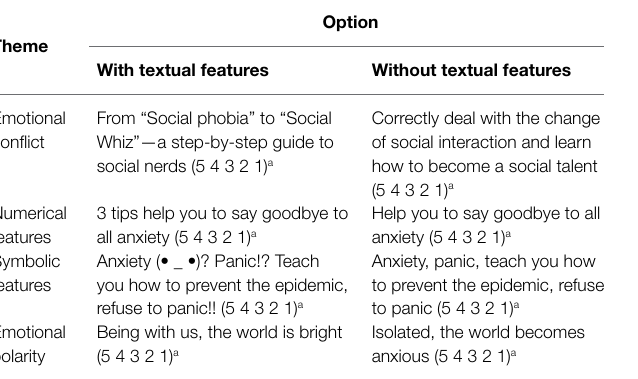
TABLE 1 | Experience materials with textual